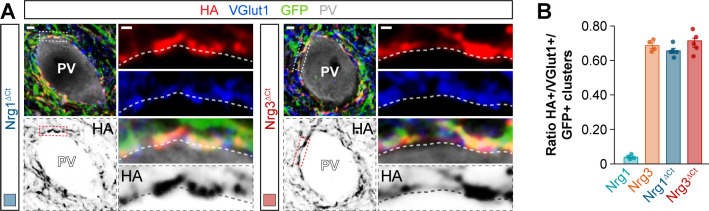
Targeting of C-terminal domain-lacking neuregulin constructs to excitatory presynaptic boutons innervating PV+ interneurons.(A) Co-localization of HA-tagged truncated Nrg1ΔCt (left) and HA-tagged truncated Nrg3ΔCt (right) (red) with presynaptic VGlut1+ boutons (blue) in GFP+ pyramidal cell axons (green) contacting PV+ interneurons (gray). The bottom panel depicts HA staining in a color-inverted image. The high-magnification images illustrate the co-localization of HA-tagged neuregulins with excitatory VGlut1+ boutons. (B) Quantification of the proportion of VGlut1+ boutons that co-localize with HA-tagged Nrg clusters in axon terminals of electroporated GFP+ pyramidal cells. Tukey’s range test for post hoc comparison between wild-type Nrg3 construct and chimeric Nrg constructs: p=0.689, n = 5 mice (38 cells) for pSyn-Nrg1ΔCt-pSyn-Gfp; p=0.928, n = 5 mice (36 cells) for pSyn-Nrg3ΔCt-pSyn-Gfp; p=0.304, for comparison between chimeric Nrg constructs. Note that data for Nrg1 and Nrg3 wild-type constructs is the same data shown in Figure 3—figure supplement 4B. Scale bars, 2 μm (A) and 0.5 μm (high magnifications). Data in synaptic quantifications represent mean ± s.e.m. The averages per animal and electroporation condition are shown in bar graphs. Data used for quantitative analyses are available in Figure 6—figure supplement 2—source data 1.
Figure 6—figure supplement 2—source data 1.Numerical data of synaptic targeting of C-terminal domain truncated neuregulin constructs in axon terminals innervating PV+ interneurons.